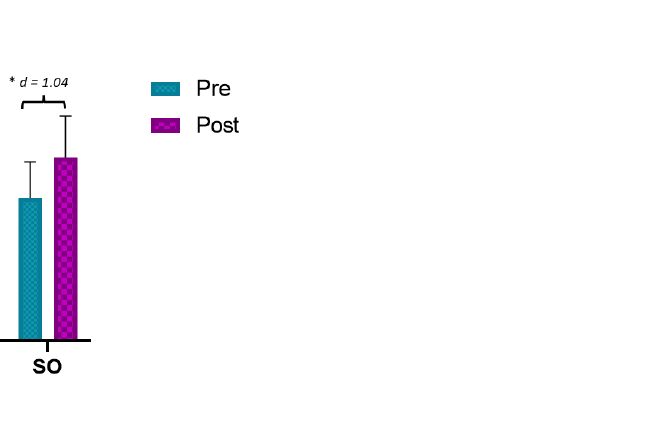
Figure 4. Main results for test score. * p < 0.05; ** p < 0.01; MIP: motor imagery practice; AOP: action observation practice; SO: Sham observation.